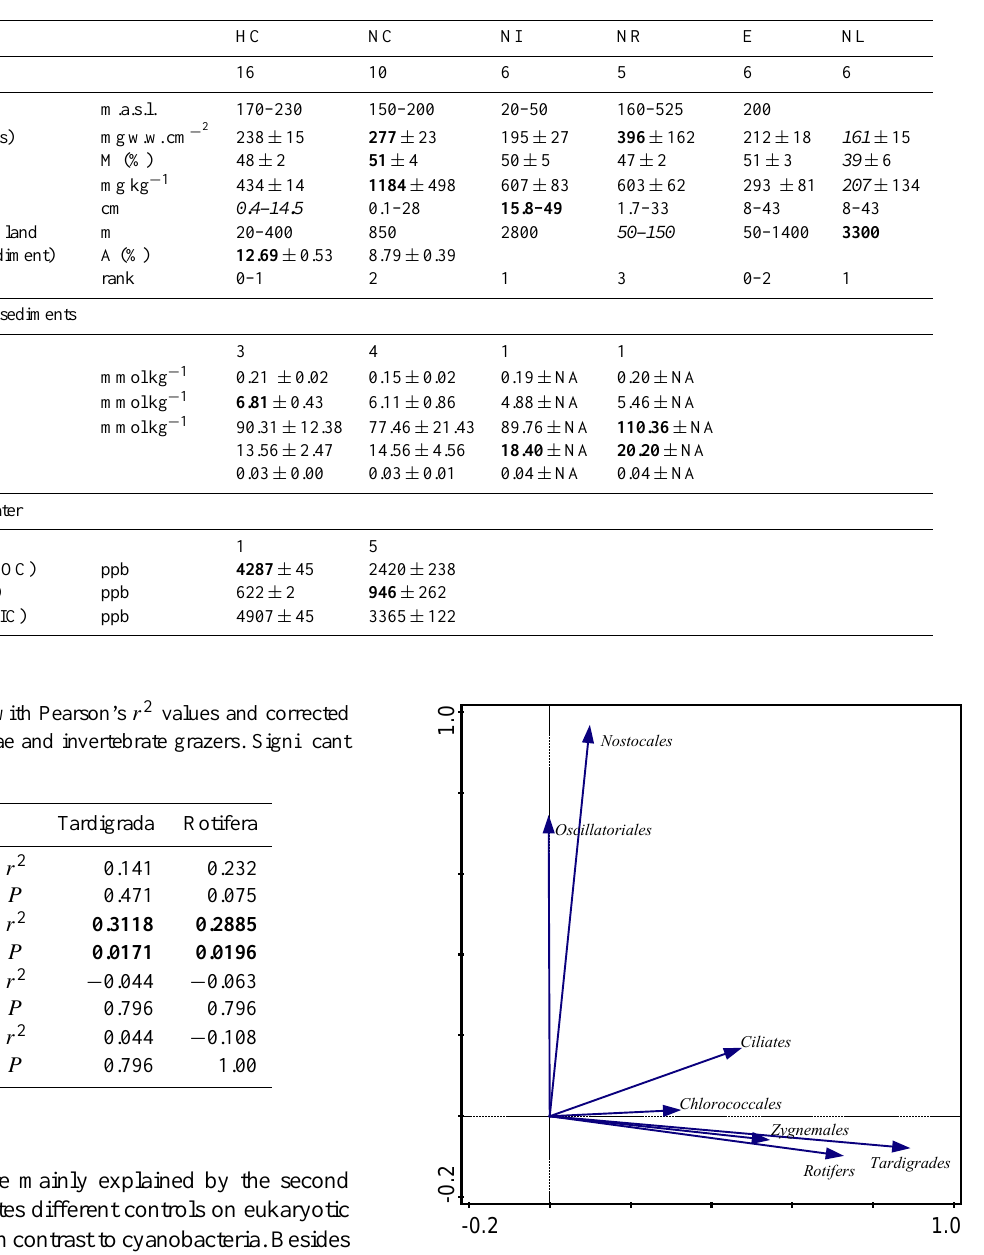
Table 3. Environmental variables for each site as ranges or averages ± the standard error. Bold numbers indicate particularly high values and italic numbers indicate low values. n indicates the samples size for the different kind of analysis. Abbreviations for the different parameters are given in brackets.